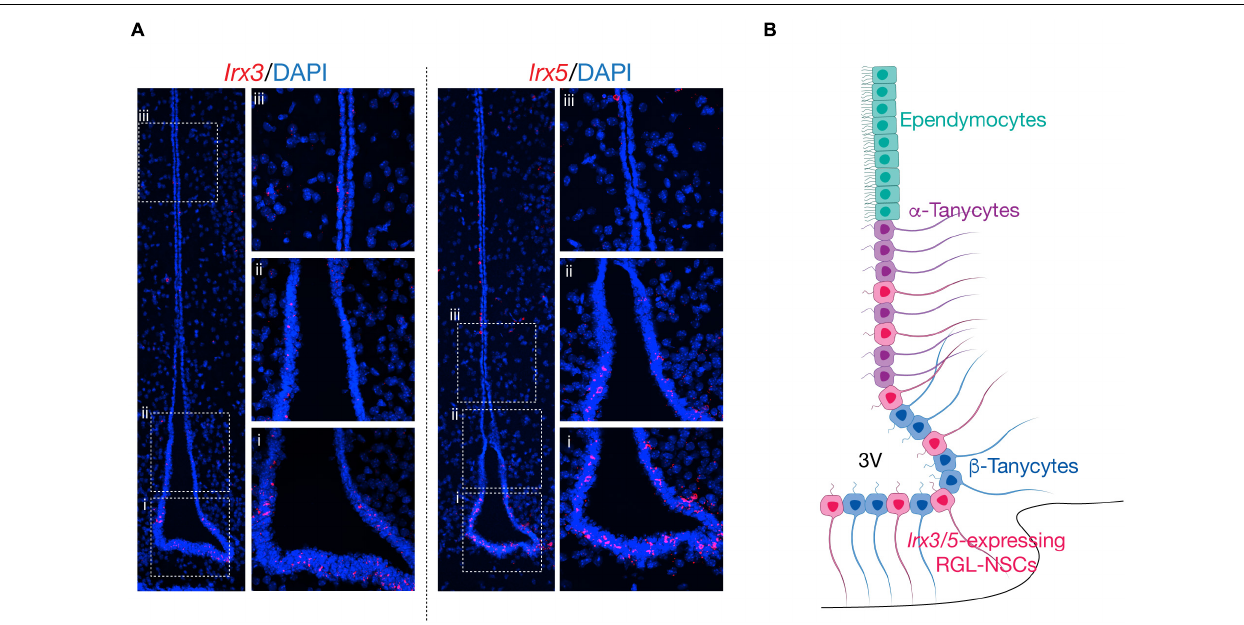
FIGURE 2 | Schematic of Irx3 and Irx5 expression in the mediobasal hypothalamus. (A) RNA in situ hybridization of Irx3 and Irx5 the mediobasal hypothalamus at postnatal day (P) 14. Irx3 and Irx5 expression is mainly found in radial glia-like cells lining the third ventricle, including RGL-NSCs, tanycytes, and ependymocytes. Panels from bottom to top (ventral to dorsal) show representative regions from: β -tanycytes (i), α -tanycytes (ii) and ependymocytes (iii). (B) Schematic of the mediobasal hypothalamus. Along the third ventricle, ependymocytes are located at the dorsal ventricular walls, followed by α -tanycytes, and β -tanycytes. Irx3 - and Irx5 -expressing RGL-NSCs are interspersed among α -tanycytes and β -tanycytes in the dorsal ventricular wall and